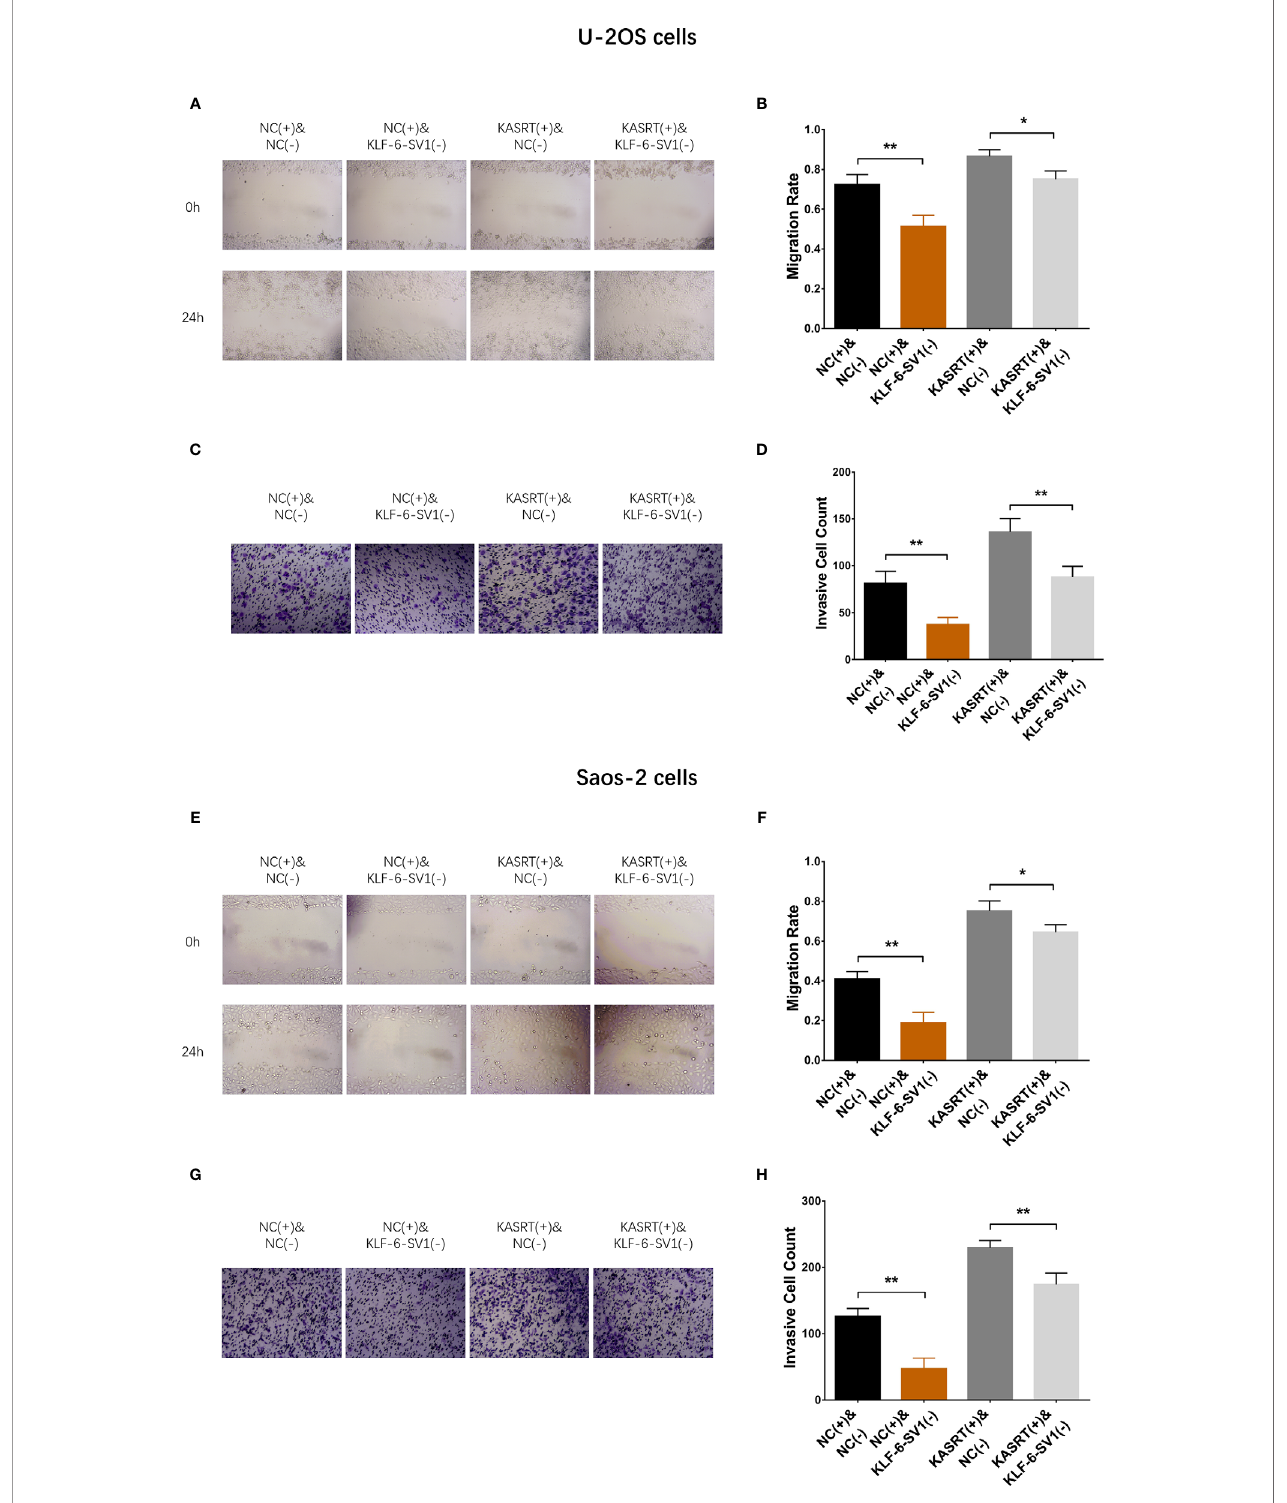
FIGURE 7 | Cell migration and invasion in compensatory experiments. In compensatory experiments, cell migration (A, B) and invasion (C, D) among groups in U-2OS cells and cell migration (E, F) and invasion (G, H) among the groups of Saos-2 cells. *P < 0.05, **P <